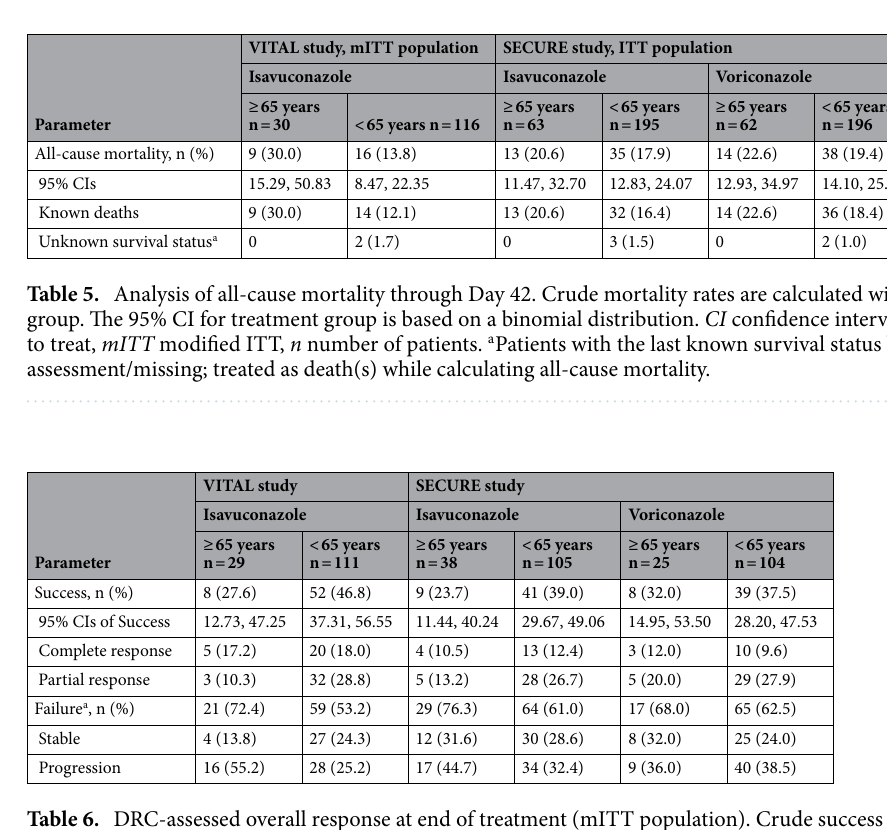
Table 6. DRC-assessed overall response at end of treatment (mITT population). Crude success rates and exact binomial CIs were calculated within treatment. Complete and partial response referred to the resolution of attributable clinical symptoms and physical findings. Failure (no resolution) was defined as no resolution and/ or worsening of any attributable clinical symptoms and physical findings. The 95% CI for treatment group is based on a binomial distribution. CI confidence interval, DRC data review committee, mITT modified intent to treat, n number of patients. a One patient with missing response had an outcome as